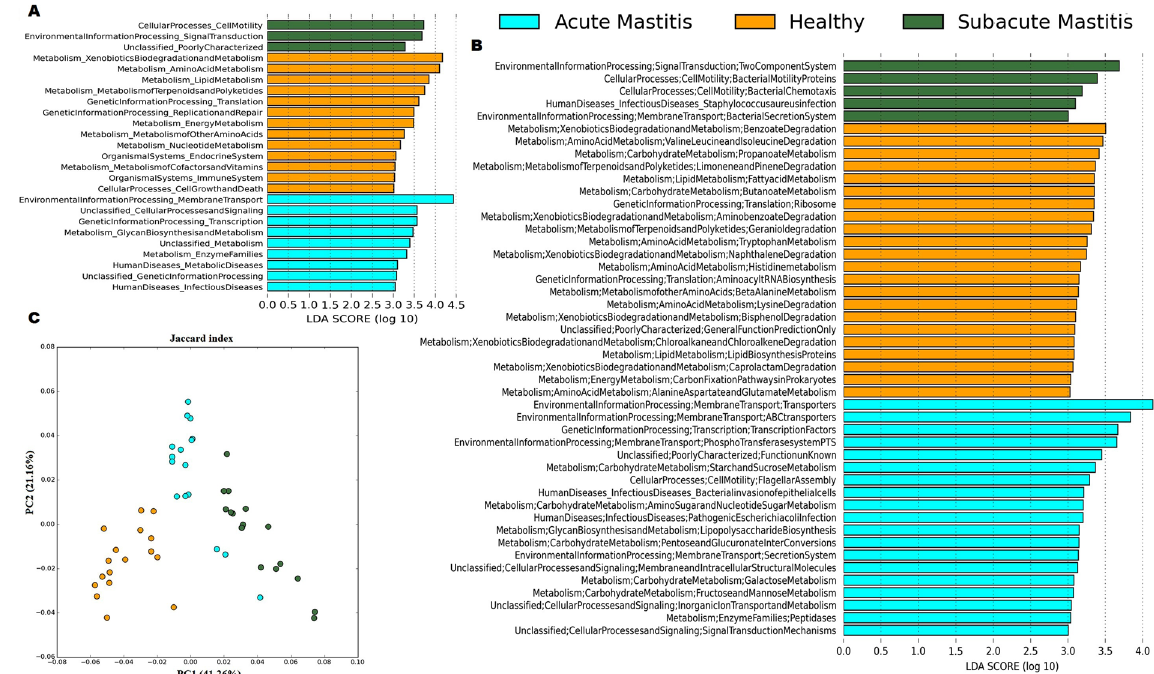
Figure 5. Predicted function of breast milk microbiota between healthy-controls, SAM and AM samples. LEfSe was used to compare abundance of predicted KEGG pathways at ( A ) level 2 and ( B ) level 3. The significant pathways were selected by Kruskal-Wallis test (P < 0.05) and LDA score of greater than 2.0. ( C ) PCoA of KOs based on Jaccard index revealed different clustering of healthy-controls from that of SAM and AM